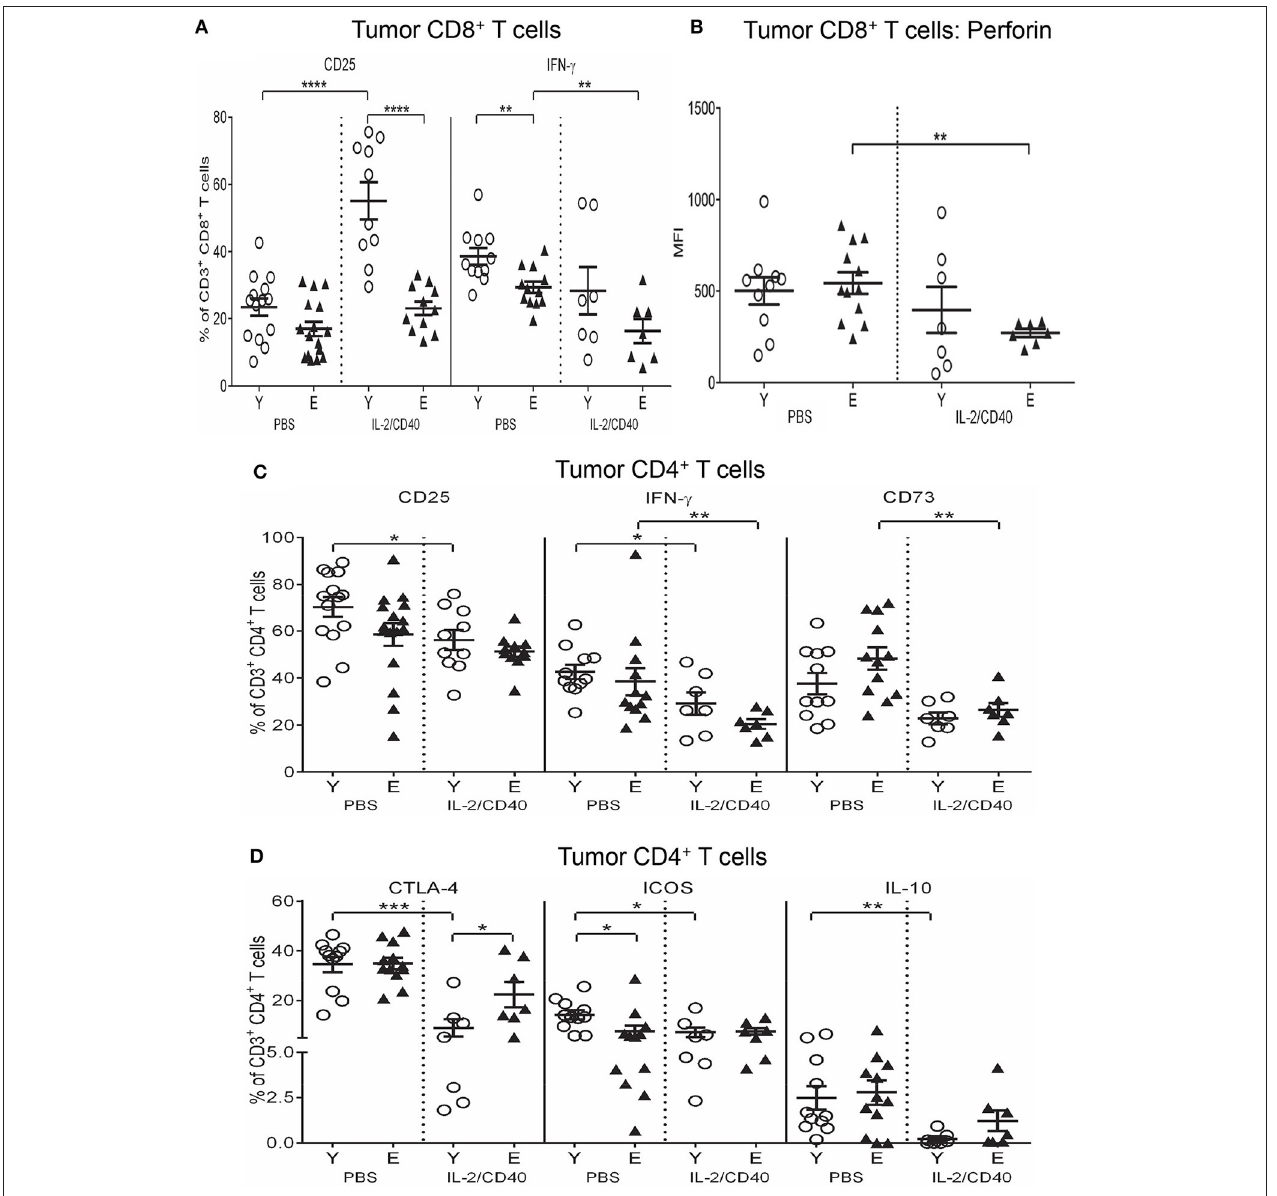
FIGURE 10 | Reduced CD25, IFN- γ and perforin on CD8 + T cells and increased CTLA-4 on CD4 + T cells in elderly IL-2/CD40-treated tumors. After two doses of IL-2/CD40 or PBS diluent, percentages of CD8 + T cells positive for CD25 and IFN- γ (A) , expression levels of perforin (shown as geometric mean fluorescence intensity; MFI) on CD8 + T cells (B) , and percentages of CD4 + T cells positive for CD25, IFN- γ and CD73 (C) and CTLA-4, ICOS and IL-10 (D) were measured in tumors from the young and elderly tumor-bearing mice described in Figures 5B,C using flow cytometry. Data are shown as mean ± SEM, n = 7–10 young and n = 7–11 elderly IL-2/CD40-treated mice, n = 11–14 young and n = 12–16 elderly PBS control mice, * p < 0.05, ** p < 0.005, *** p < 0.0005, **** p < 0.0001 comparing (i) young to elderly mice, or (ii) IL-2/CD40-treated mice to age-matched PBS control mice. and tumors ( p = 0.1; Figure 11B ) whilst no increase in